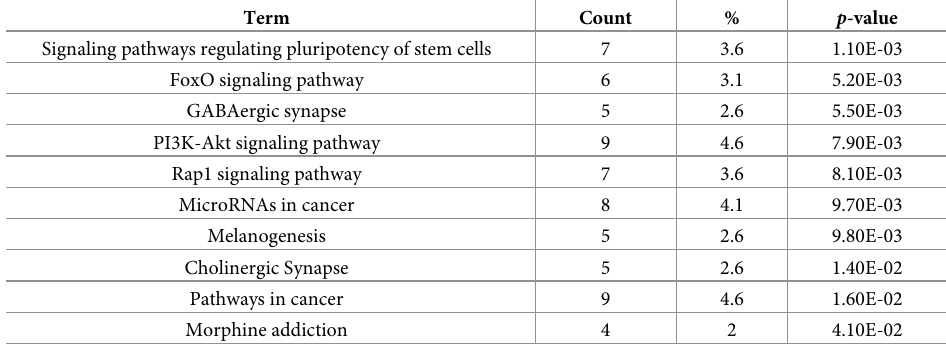
Table 6. Kyoto Encyclopedia of Genes and Genomes (KEGG) enrichment pathway analysis of miR-181b-5p, miR- 222-3p and let-7a-5p target genes. Term Signaling pathways regulating pluripotency of stem